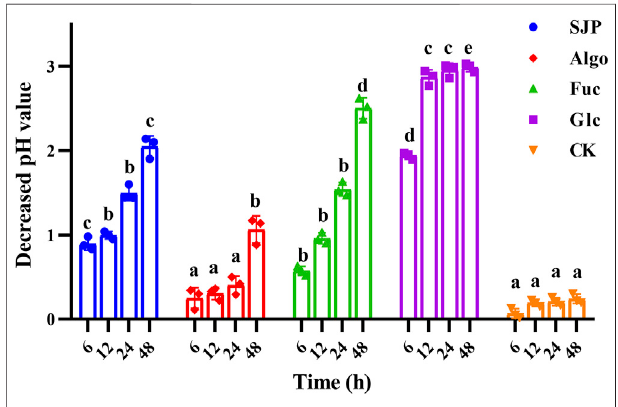
FIGURE 3 | pH variation during in vitro degradation. The pH reduction duringthe invitro degradationofSJP,alginateoligosaccharides(Algo),fucose (Fuc),andglucose(Glc).Thecontrolcondition(CK)wasachievedbyexcluding the addition of experimental substances. Results are shown as mean ± SD ( n (cid:2) 3). a,b,c,d Signi fi cant differences were analyzed by one-way ANOVA with post-hoc Tukey HSD test for multiple groups comparisons at the same fermentation time ( p < 0.05). SJP, seaweed Laminaria japonica polysaccharides; HSD, honestly signi fi cant